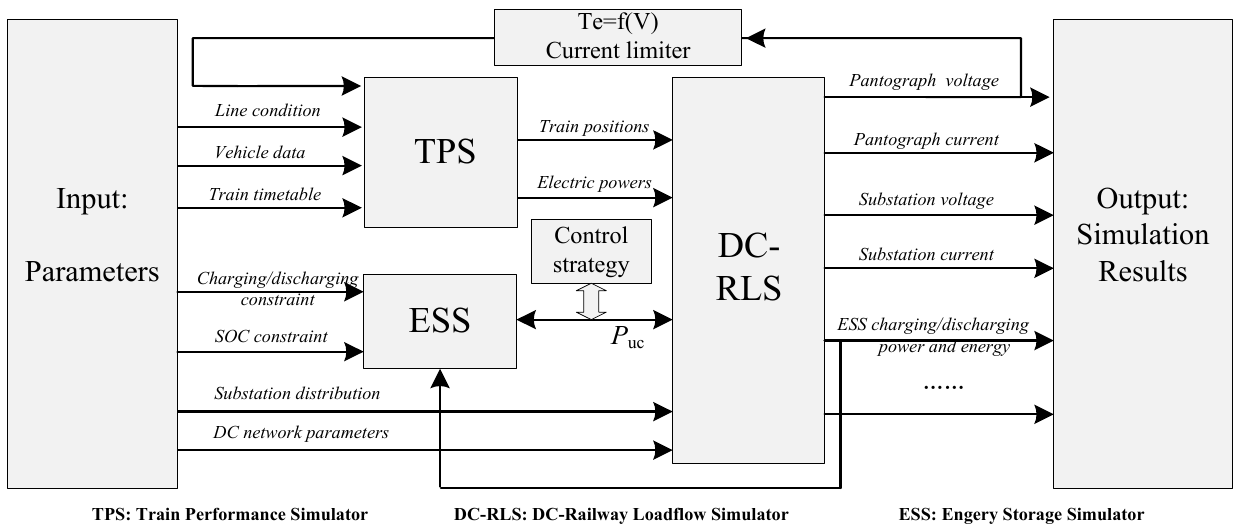
Figure 4. Simulator for ultra-capacitor energy storage